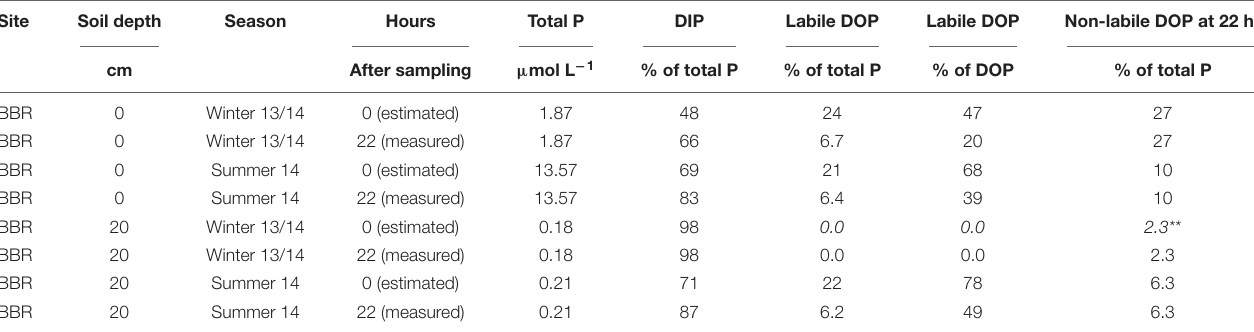
TABLE 5 | Back-estimation of fractions of phosphorus (P) forms to the time point of sampling in leached soil solutions from the litter and the A horizon (20 cm depth) in winter 2013/2014 and summer 2014 at the P-rich site Bad Brückenau (BBR). Site Soil depth